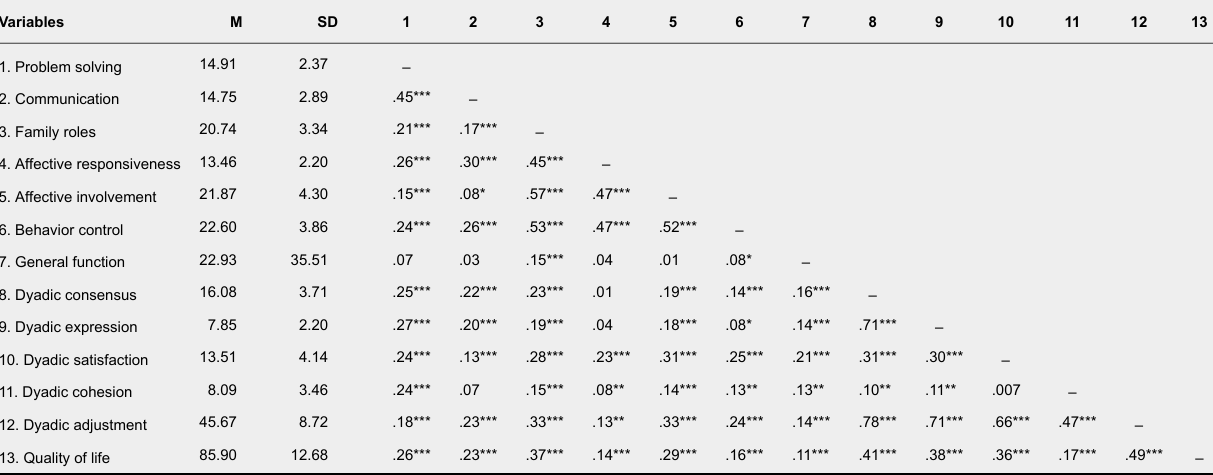
Pearson Correlations of Family Functions and Dyadic Adjustment With Quality of